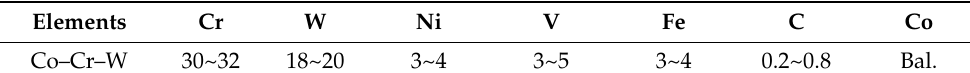
Table 1. Chemical compositions of Co-Cr-W alloy powder (wt.%).